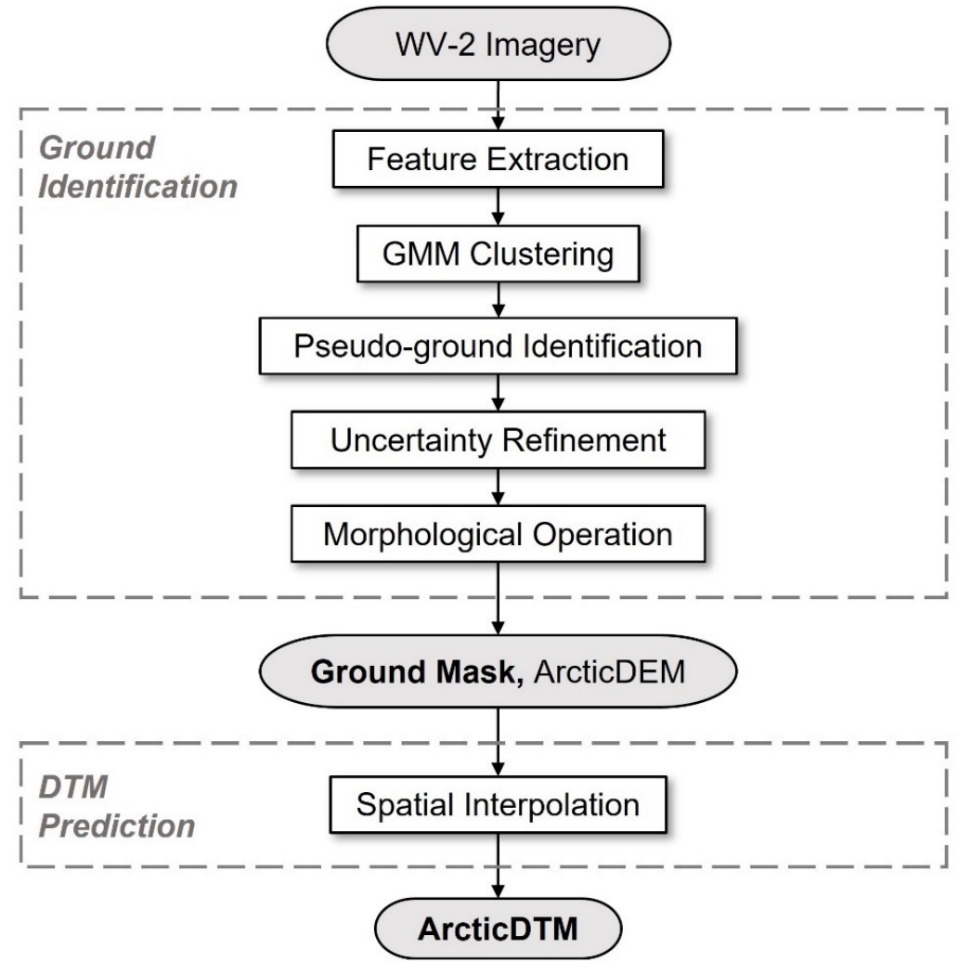
Figure 3. Flowchart of the proposed method. Bold letter indicates the output from the last step. GMM clustering (using the GaussianMixture function in Python sklearn.mixture pack- age [49]) was initialized by the K-means clustering, and the fitting of the Gaussian mixture or the parameter optimization step was then realized by the expectation-maximization algorithm [50]. Once the parameters ( π k , µ k , Σ k , Equation (1)) are determined, the cluster membership probability of the i -th observation ( x i ) corresponding to the k -th Gaussian ( x i | µ k , Σ k ) , component can be obtained by π k N , which quantifies the clustering uncertainty. ∑ m ( x i | µ k , Σ k ) k = 1 π k N The clustering uncertainty encodes critical information for evaluating the confidence of each pixel’s clustering result. This information was then used for refining the initially identified pseudo-ground cluster in Step 2: ground mask